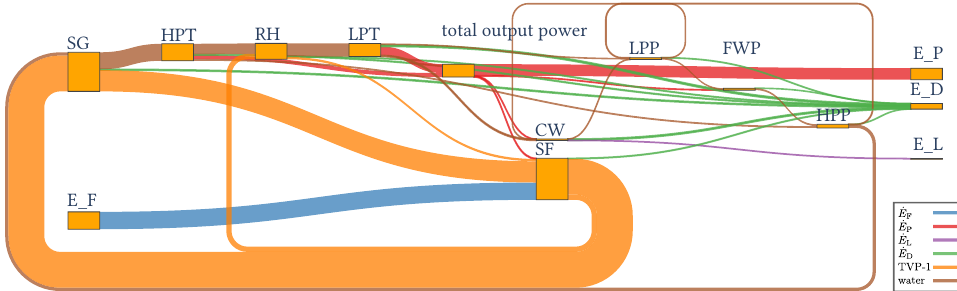
Figure 6. Machine-generated Grassmann diagram based on functional groups of SEGS. The value of the exergy flows are shown in a true-to-scale manner by the width of the edges.